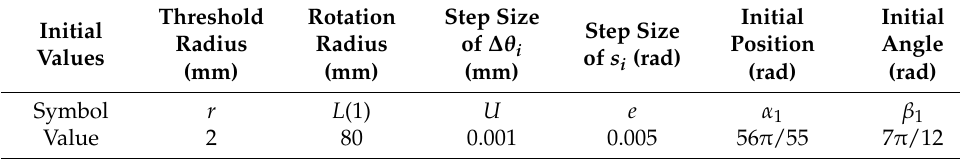
Table 1. Initial values of the optimization